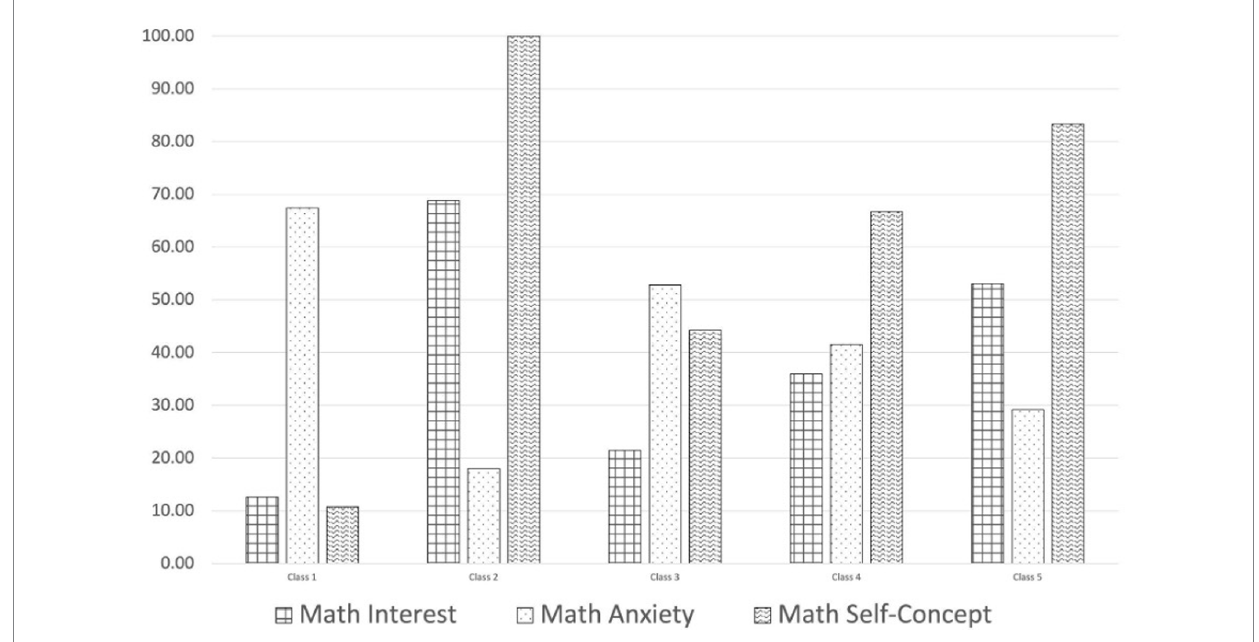
FIGURE 2 Conditional means of math interest, math anxiety, and math self-concept for the preferred five class solution.